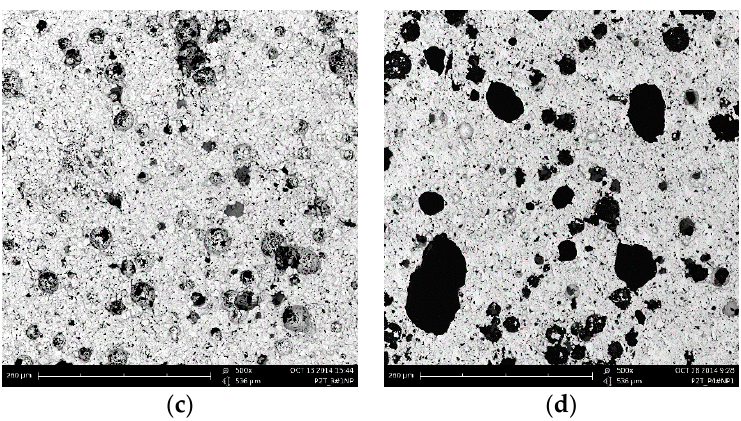
Figure 1. SEM micrographs of poled ceramics with different porosities: ( a ) porosity ≈ 5% (0 wt % PMMA); ( b ) porosity ≈ 11% (1 wt % PMMA); ( c ) porosity ≈ 15% (2 wt % PMMA); ( d ) porosity ≈ 18% (3 wt % PMMA). Table 1. The value of calculated porosity.